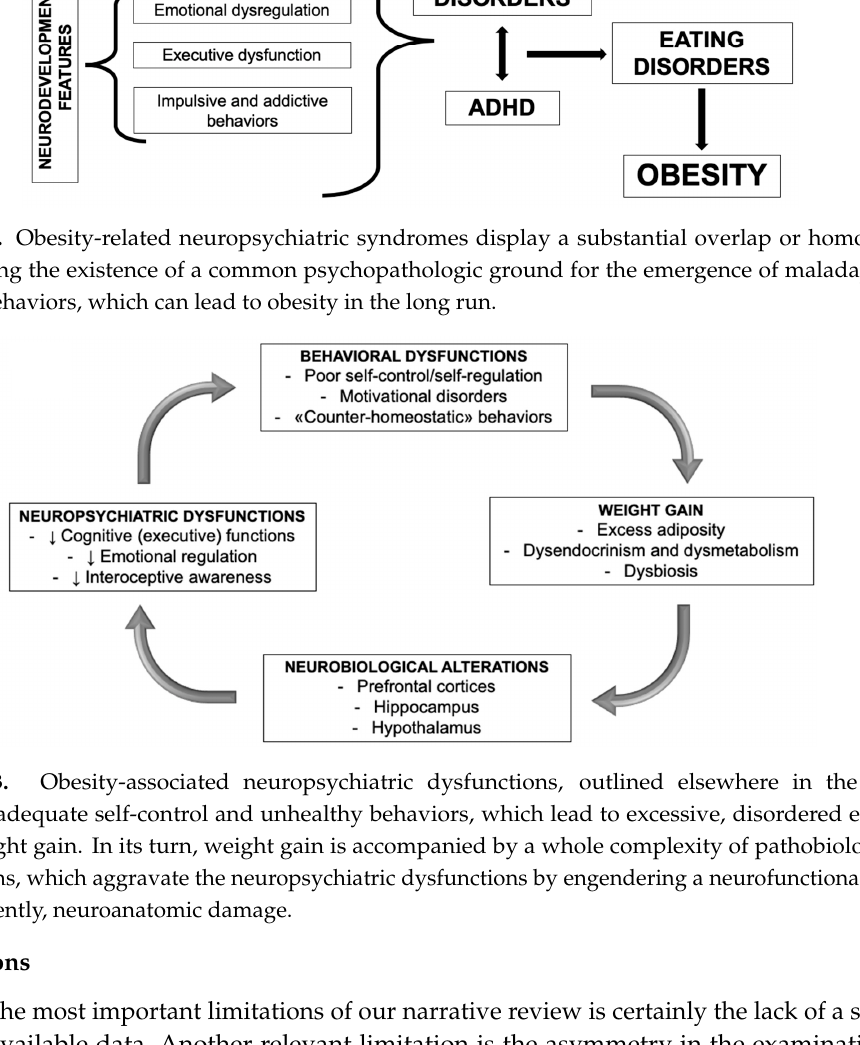
Figure 2. Obesity-related neuropsychiatric syndromes display a substantial overlap or homology, suggesting the existence of a common psychopathologic ground for the emergence of maladaptive eating behaviors, which can lead to obesity in the long run.